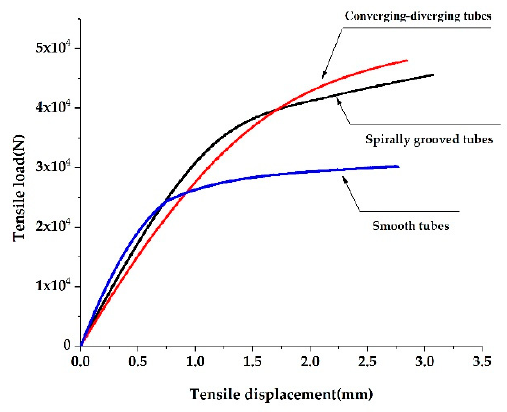
Figure 2. Comparison of experimental load-deformation curves of the two HEHE tubes and a smooth tube.